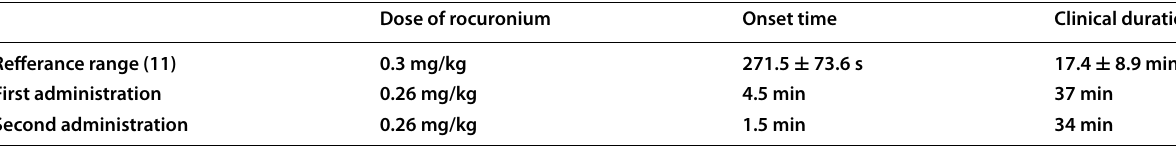
Data are presented as (mean